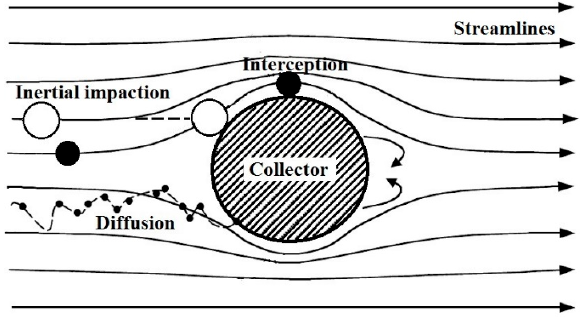
Figure 2. Schematic presentation of individual collection mechanisms at a single collector.